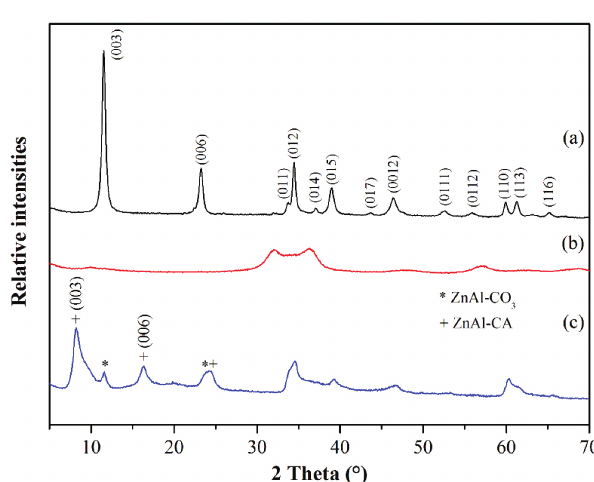
Fig. 7 – Powder XRD patterns of LDH (a), CLDH (b), and ZnAl-CA phase obtained after retention of CA (c) (m = 30 mg, [CA] = 500 mg L –1 , pH = 5, tc = 2 h) CLDH